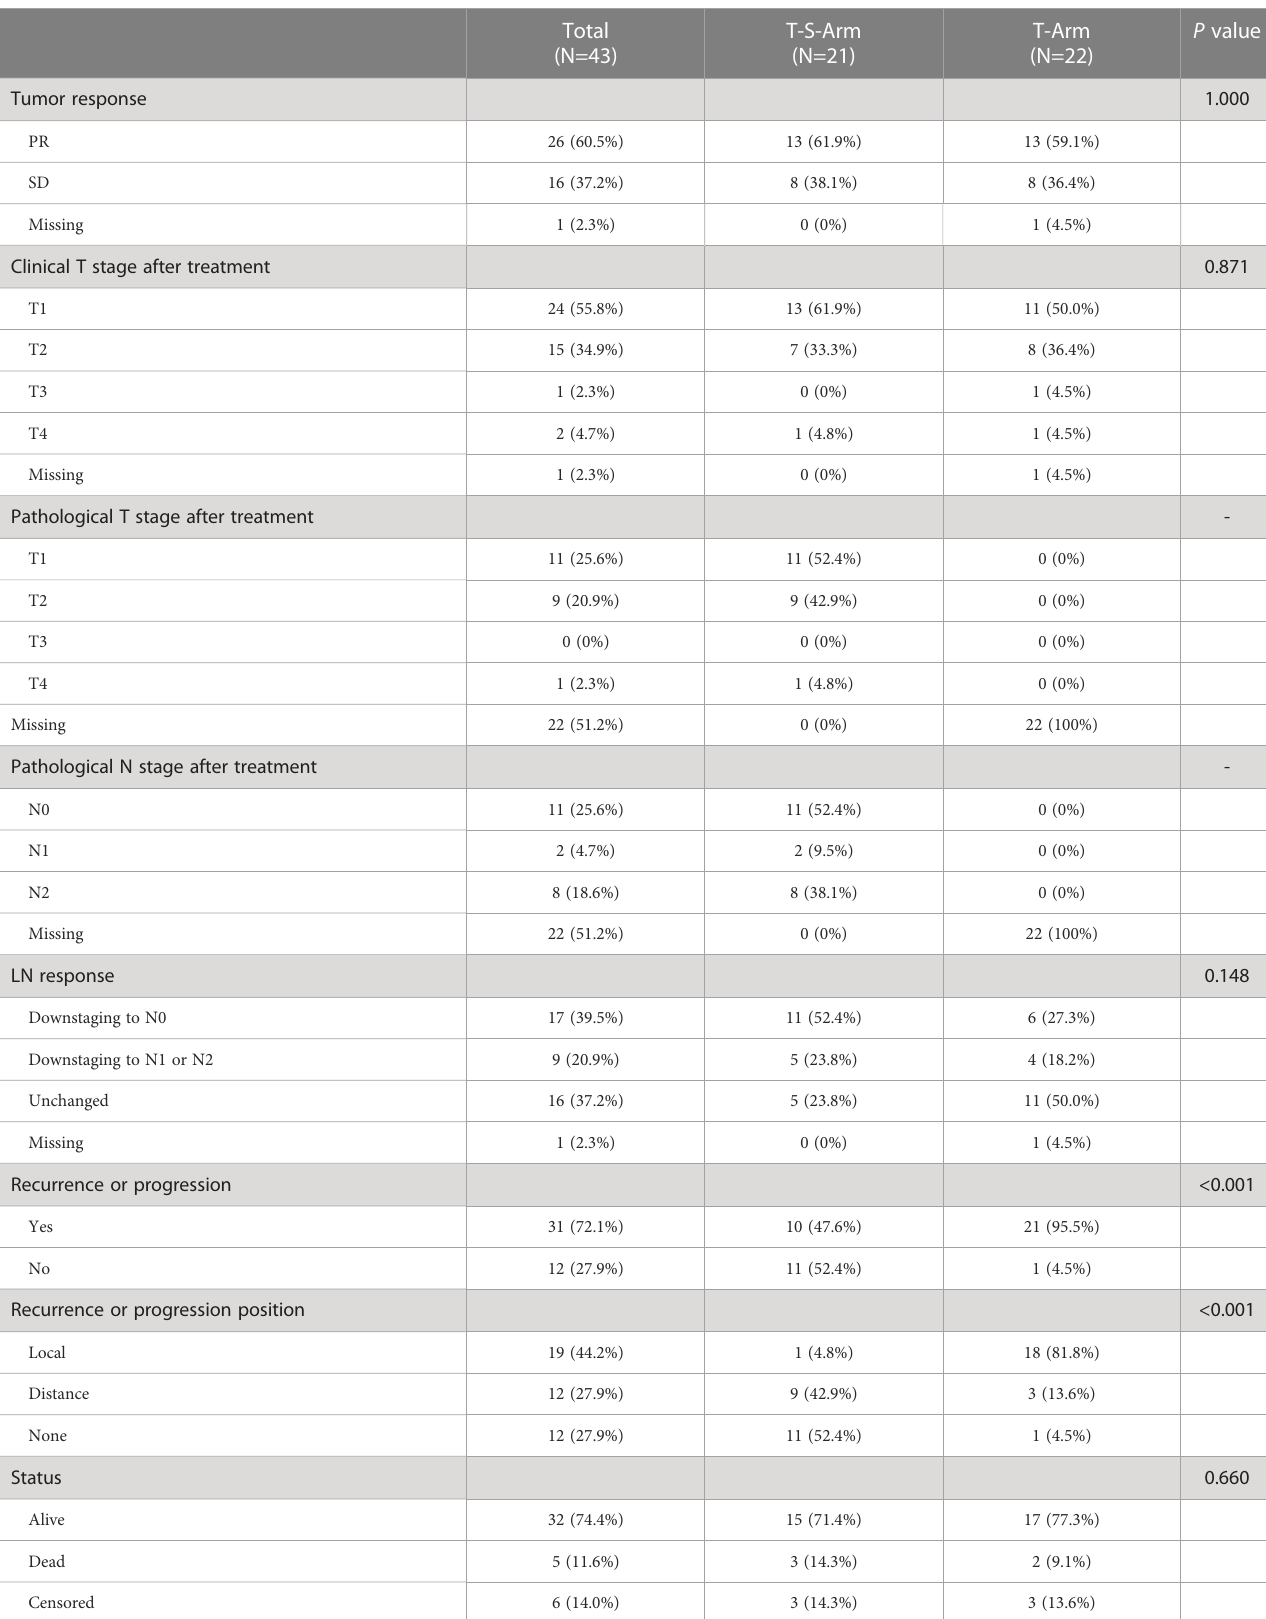
TABLE 2 Ef fi cacy of patients receiving neoadjuvant EGFR -TKI plus complete resection or EGFR -TKI alone.